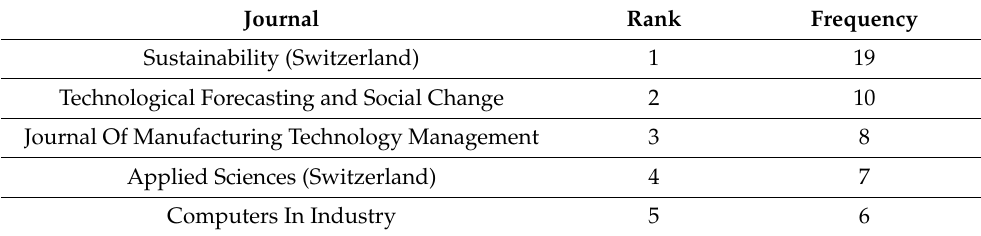
Table 3. Top 5 Sources in Zone 1 (Bradford’s